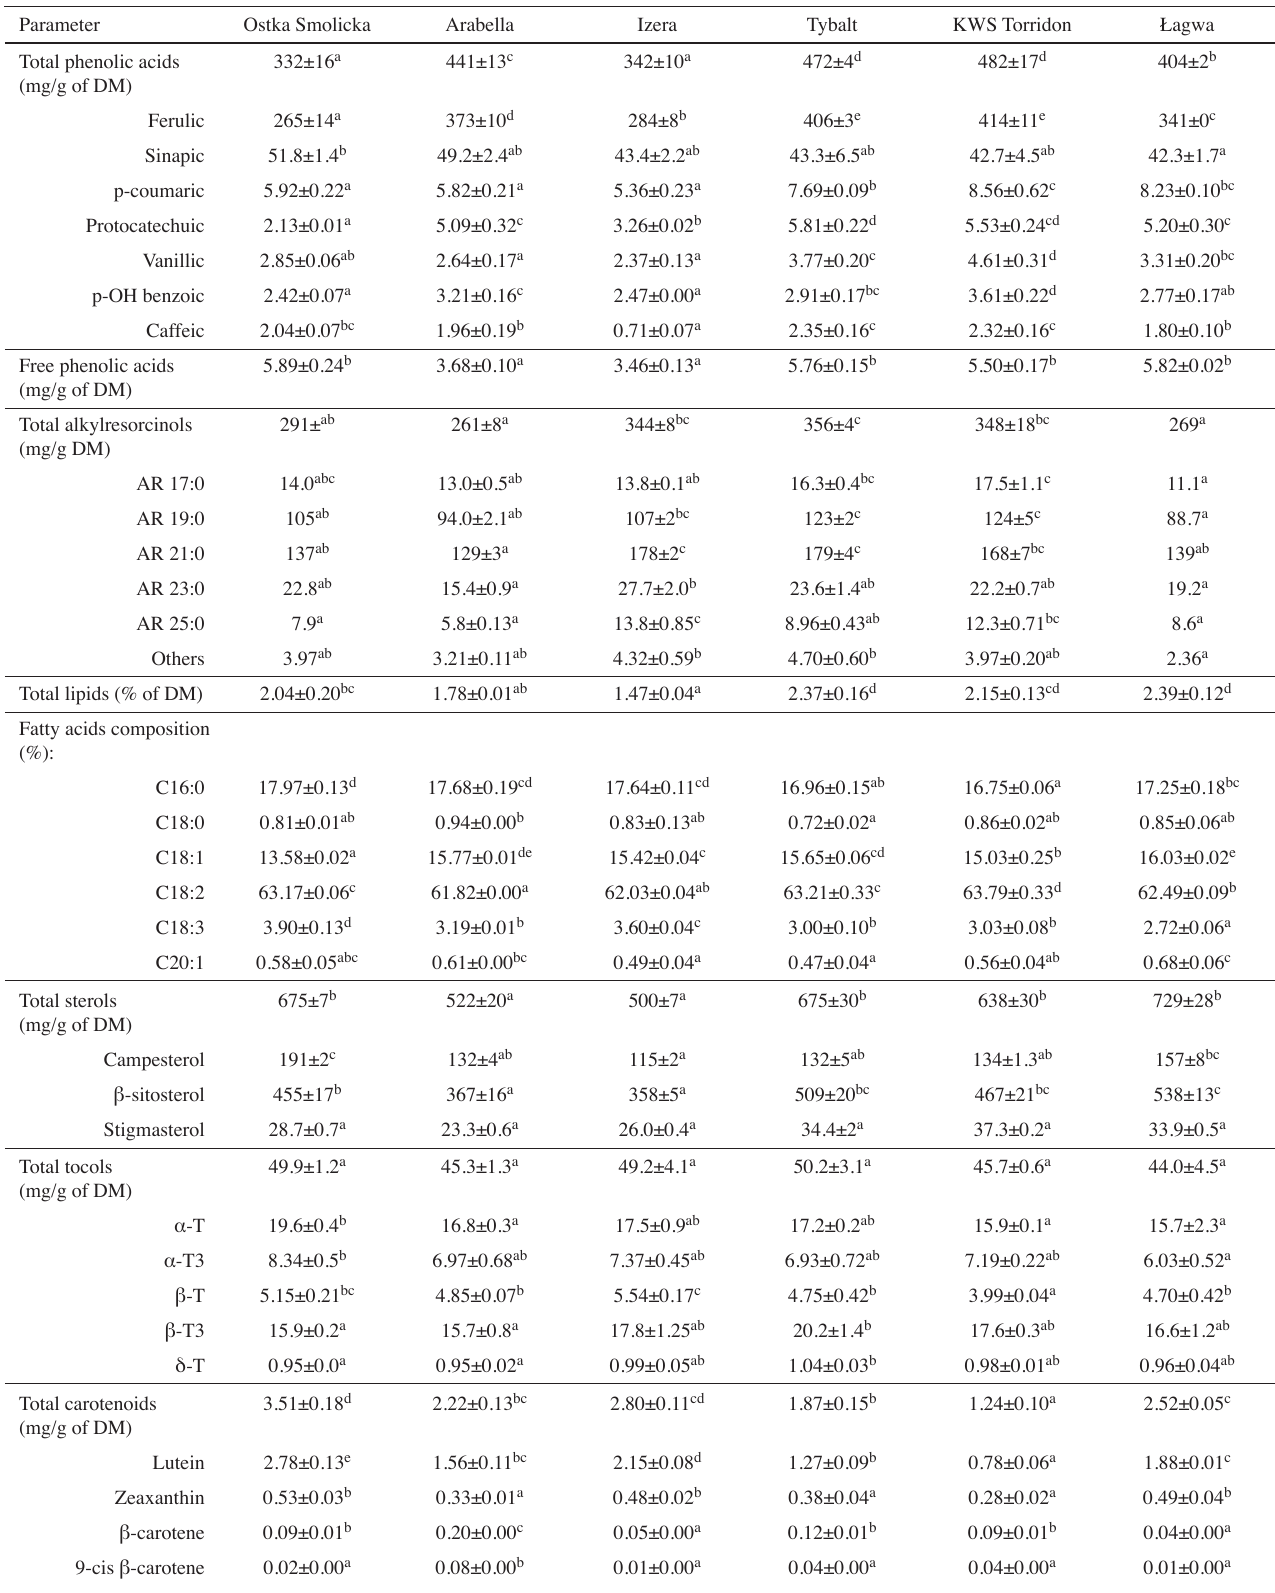
Tab. 2: Quantification of phenolic and lipophilic compounds in grain of the studied spring wheat cultivars.